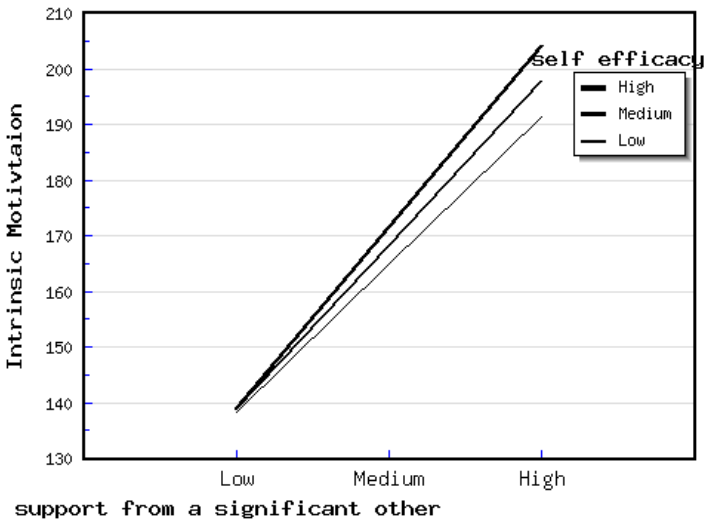
Figure 2: Showing the effect of social support from a significant other on intrinsic motivation as moderated by